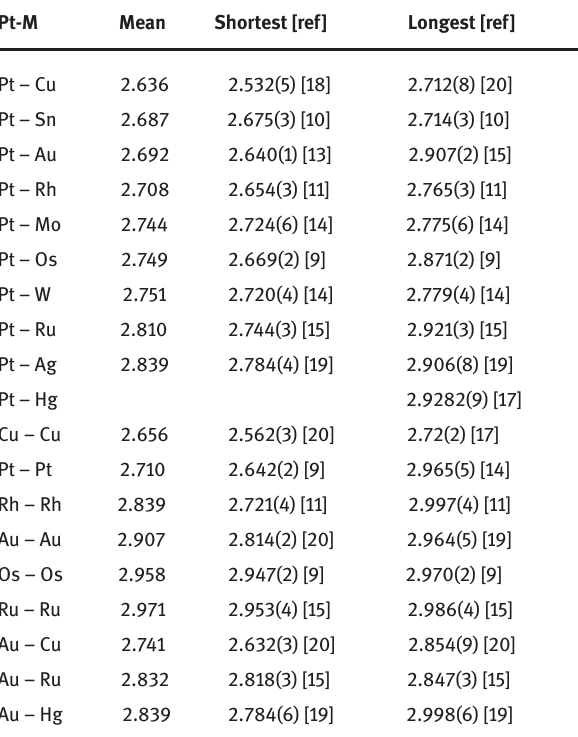
Table 2. Summary of the metal-metal bond distances (< 3.0 Å) in heteroundecanuclear platinum